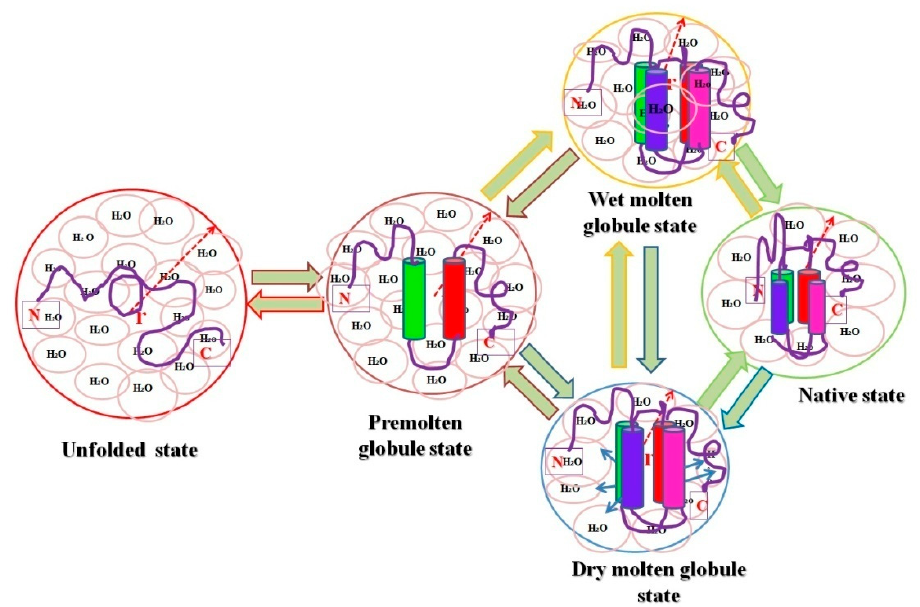
Figure 1. Pictorial representation of relative hydrodynamic volumes of different intermediate states of proteins. The figure shows an ordered secondary structure (cylinder shaped) and water molecules associated with each state (pink circles), and the arrows in dry molten globule (DMG) state represent an increase in the size towards the native state exclusive of water diffusion.